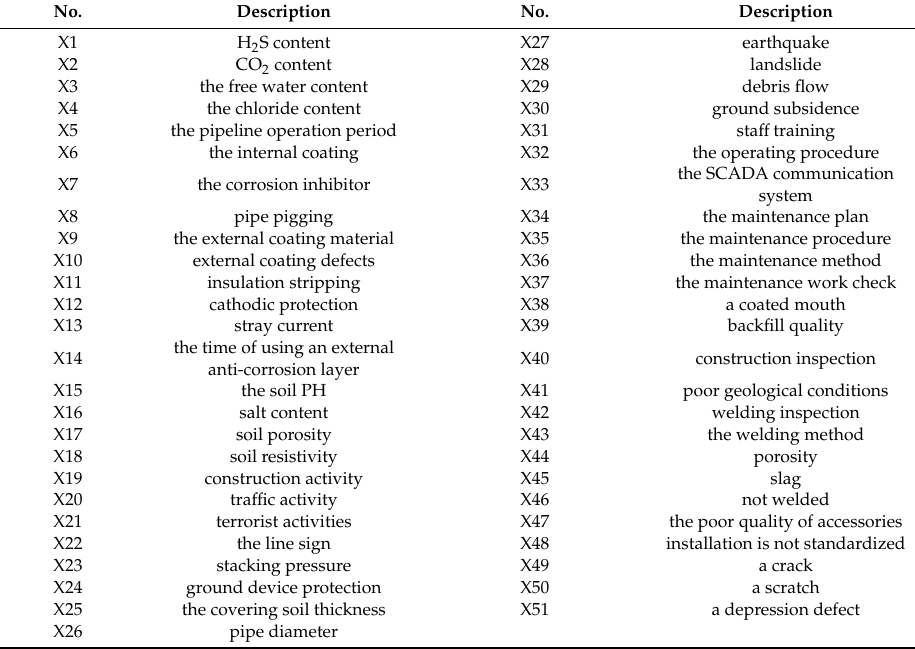
Table 5. Descriptions of root nodes in the BT model.